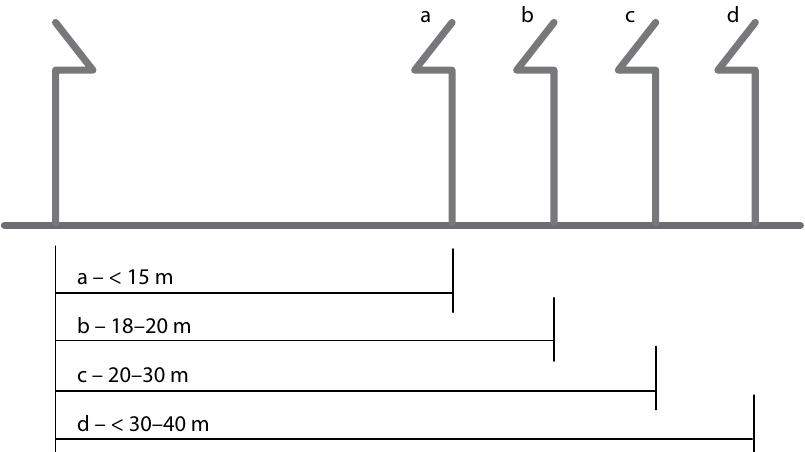
2 pav. Įvairaus pločio gatvių naudojimo pėsčiųjų gatvės funkcijai galimybės: a – tinka pėsčiųjų srautams judėti ir vitrinoms apžvelgti; b – jose galima statyti konteinerius su gėlėmis, žemais krūmais ir lauko baldus; c – galima įrengti trumpalaikio poilsio ir kavinių aikšteles, sodinti pavienius medžius; d – galima įrengti poilsio ir pramogų aikšteles, sodinti nedideles želdinių grupes, alėjas ir pan. Fig. 2. Possibilities of applying streets of different width for the function of pedestrian streets: a – that can be used for the motion of pedestrian streams as well as observing and looking over shop – windows; b – that can be used for expanded entrances, also it is possible to put containers with flowers, dwarf bushes and outdoor furniture; c – that can be used for arranging sites for short – term recreation and grounds near cafes, planting low trees; d – that can be used for installing recreation and entertainment grounds, planting small groups of greenery,